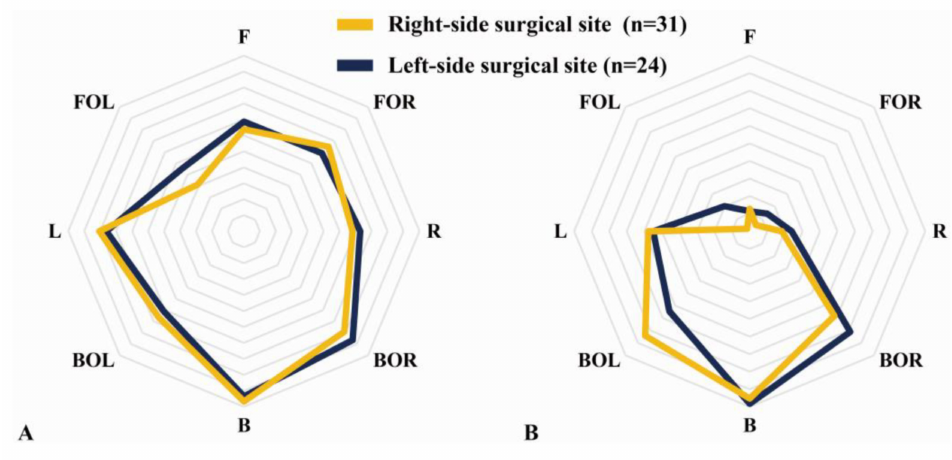
Figure 5. Core muscle asymmetry according to the difference between the right and left sides of the